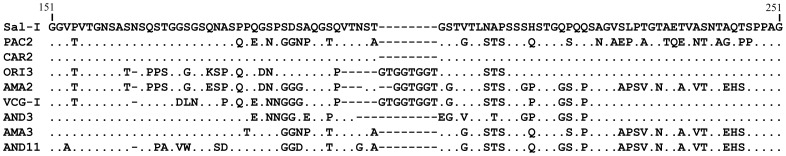
Alignment of deduced PvMSP-7H amino acid sequences, including the Sal-I sequence.The alignment shows major allele types found in Colombian populations. Dots indicate conserved residues and dashes represent gaps introduced for alignment.